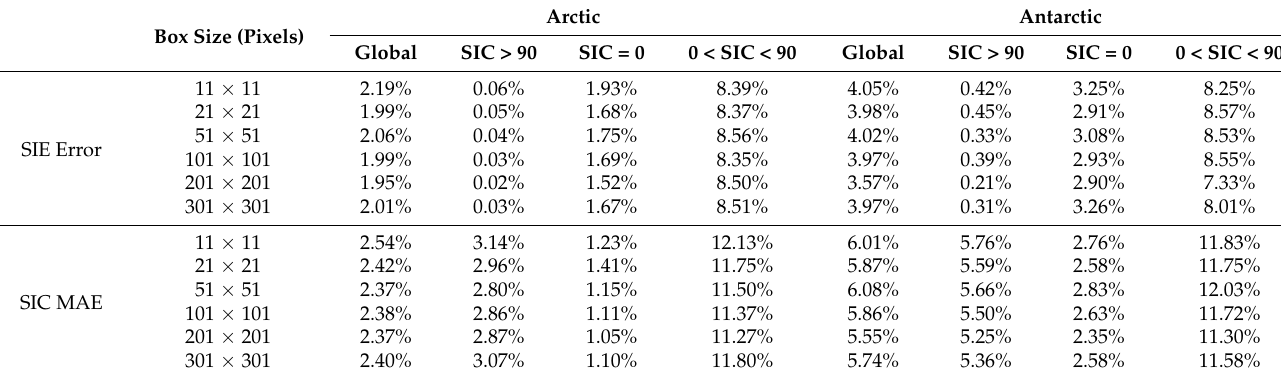
Table 2. MWR NN error with respect to LCF box